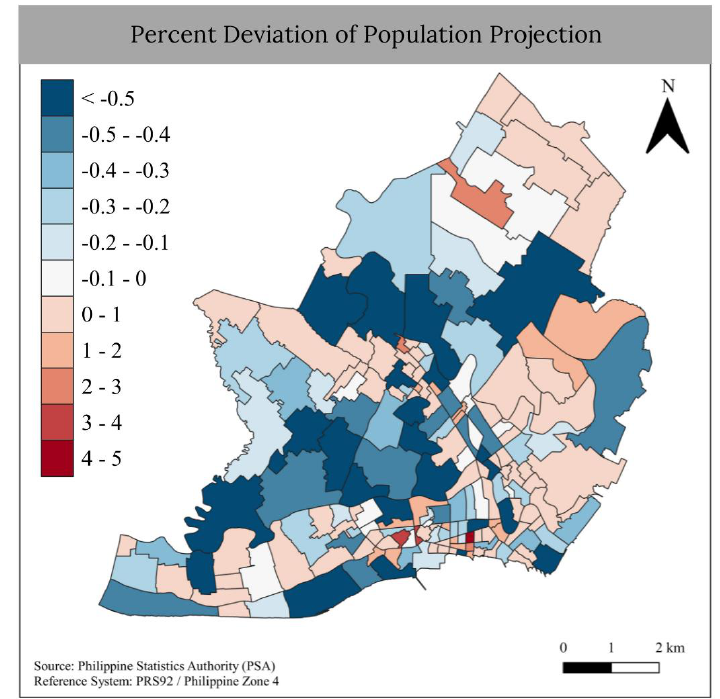
Figure 6. Percent deviation of the projected population from the actual population of Iloilo City for